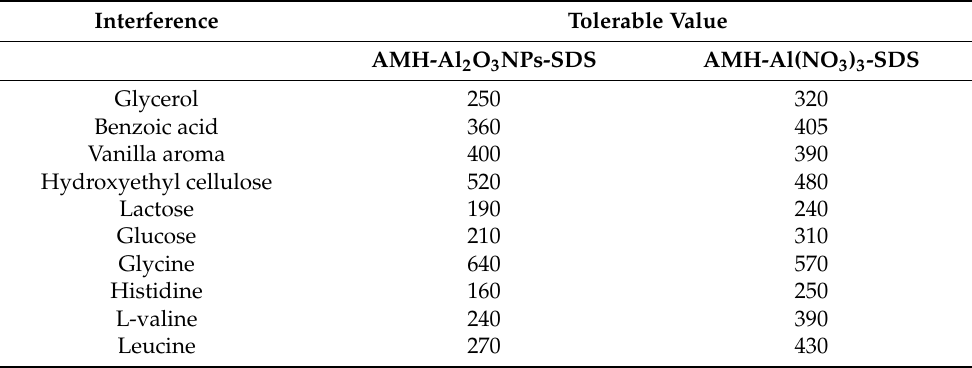
Table 4. Influence of foreign substances on the analysis of AMH using the suggested